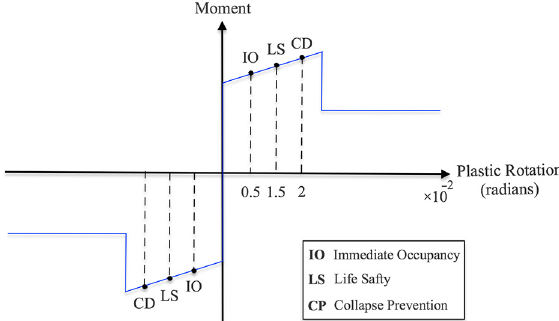
Fig. 2. Performance levels for elastoplastic behaviour of beams and